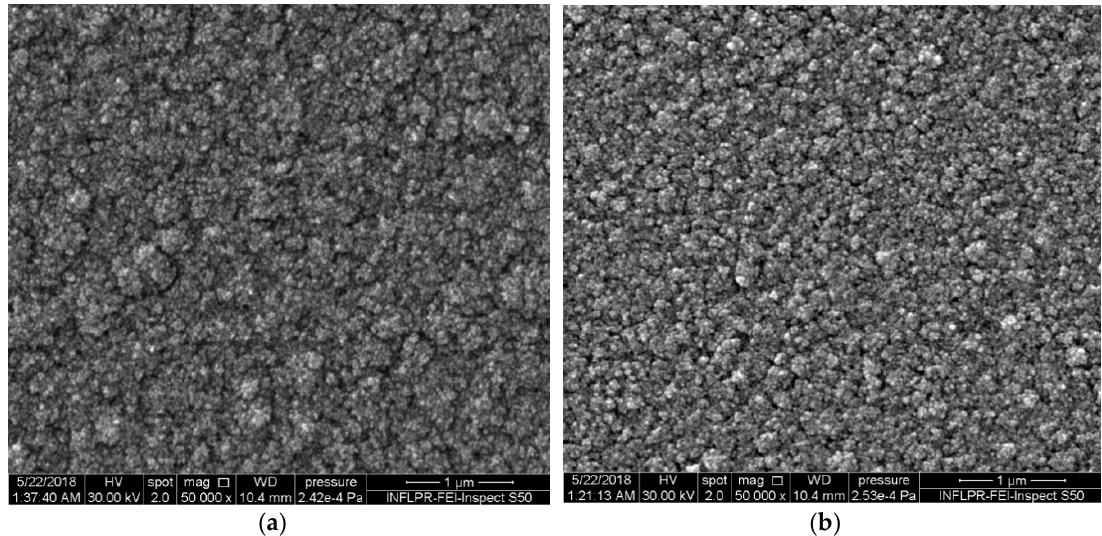
Figure 1. SEM images of the surfaces of WO 3 thin films deposited in 500 mTorr O 2 at different substrate temperatures. ( a ) 300 °C and ( b ) 600 °C.